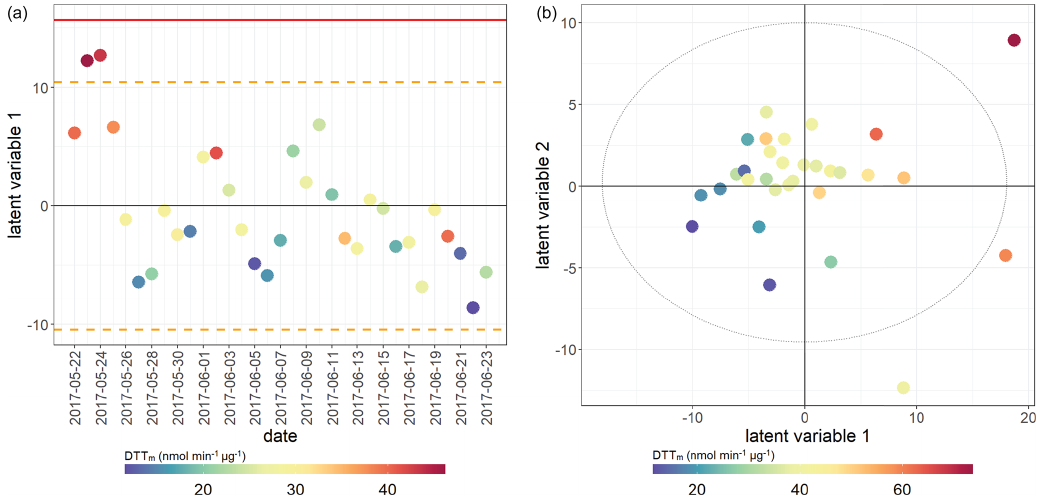
Figure 9. PLSR score plot for DTT m assay. Model performance parameters given in Table 2. (a) Winter samples; (b) summer samples. Points coloured by overall DTT assay response for both